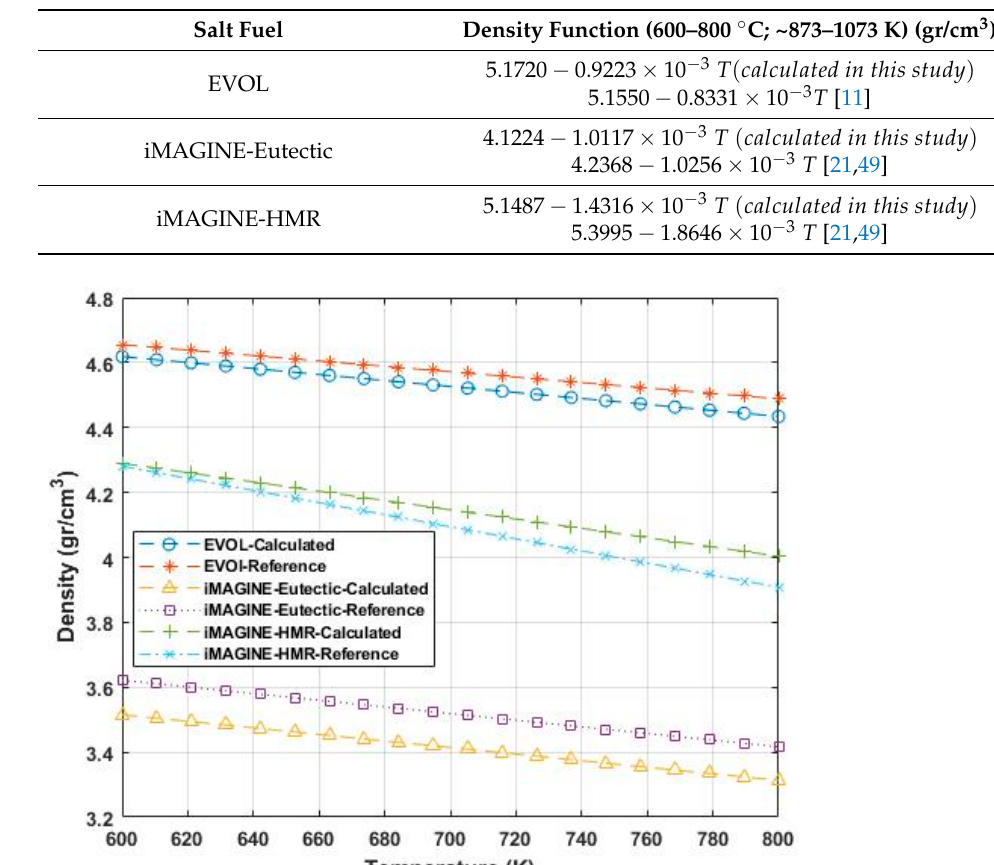
Table 5. Calculated density functions as temperature for EVOL and iMAGINE salt fuel systems [47,48].